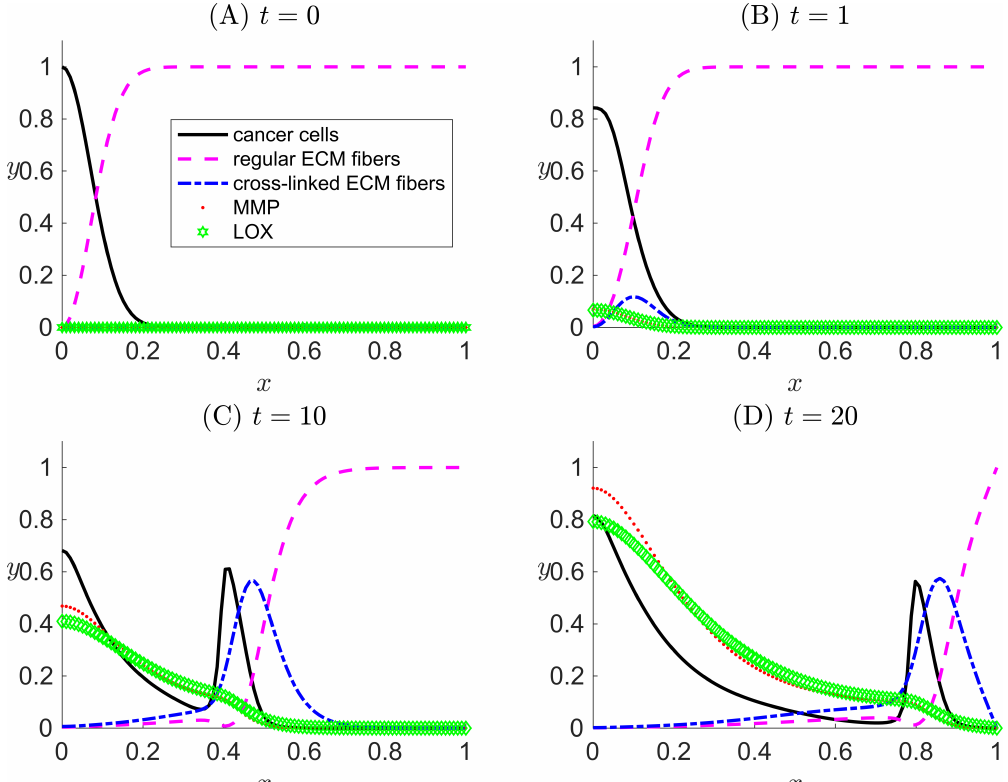
Figure 4. One-dimensional numerical results for Case III when LOX ( l (cid:54)≡ 0) and its effects both on the ECM collagen fibers and cancer cells motility are considered in the modeled system. Results are snapshots of the system dynamics at four simulation times: ( A ) t = 0, ( B ) t = 1, ( C ) t = 10, and ( D ) t = 20. For all four plots, the horizontal axis x indicates the dimensionless spatial position, and the vertical axis y indicates the dimensionless population density or concentration of the species listed in the